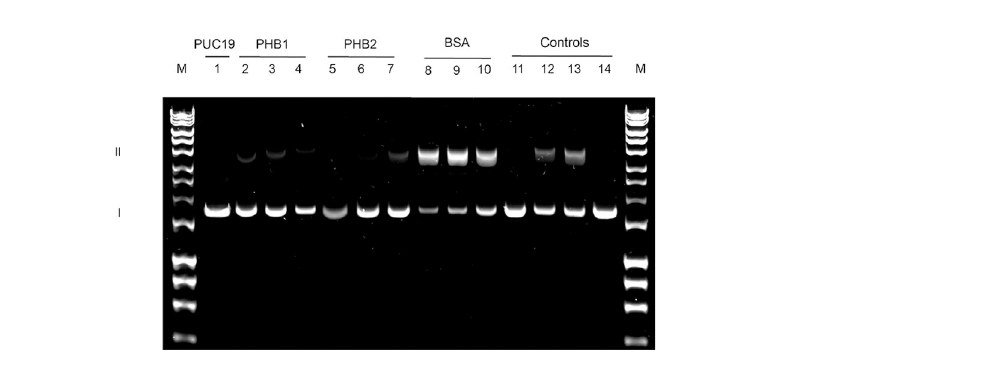
Fig 8. Supercoil DNA relaxation assay and ROS quantification assays by flow-cytometry. Agarose gel electrophoresis of pUC19 DNA after being exposed to ROS. Lane 1: DNA; lanes 2–4: DNA plus 50 μ M FeCl 3 , 10 mM H 2 O 2 and decreasing PHB1 concentrations of 500, 250 and 125 μ g/mL, respectively. Lanes 5–7: DNA plus 50 μ M